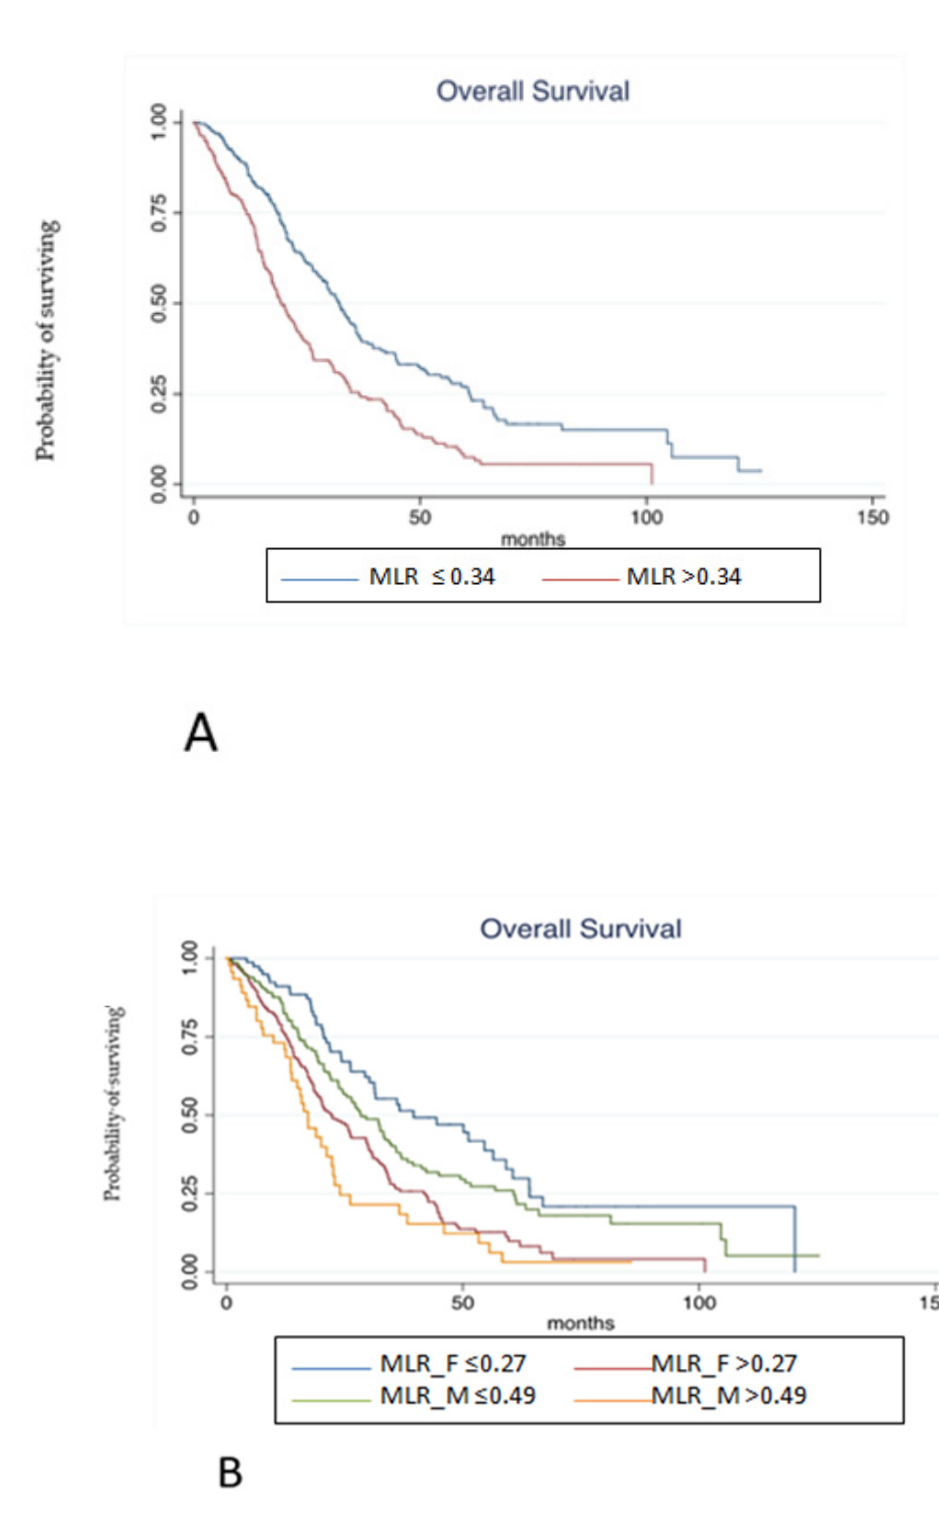
Figure 3. ( A ). Kaplan-Meier estimates of overall survival from random assignment according to MLR in overall population. ( B ). Kaplan-Meier estimates of overall survival from random assignment according to MLR in the distinct gender categories.